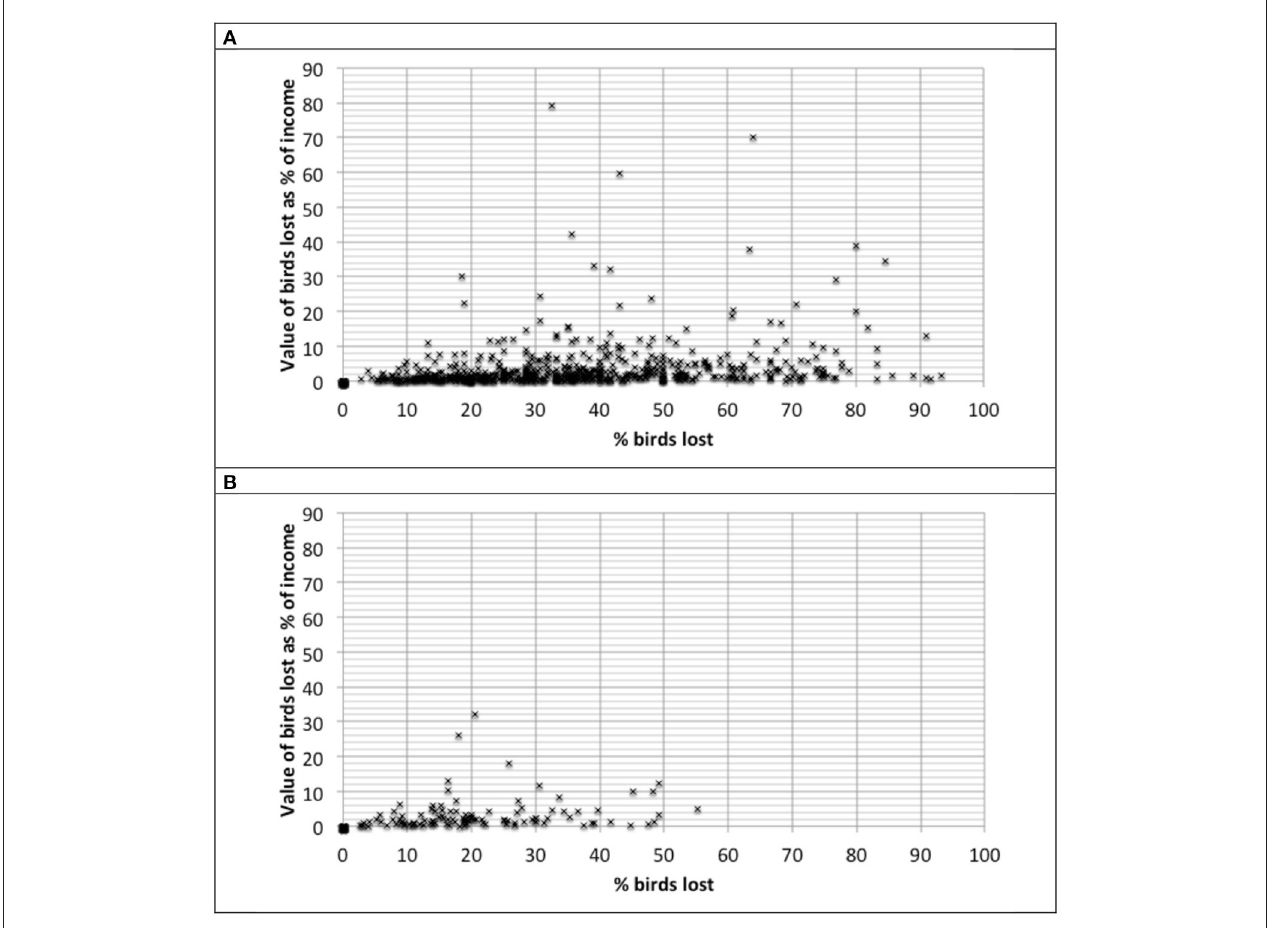
FIGURE 1 | Relationship between the proportion of birds lost to disease and the value of lost birds as proportion of annual household income. (A) Flocks of 1–20 birds. (B) Flocks of 21–50